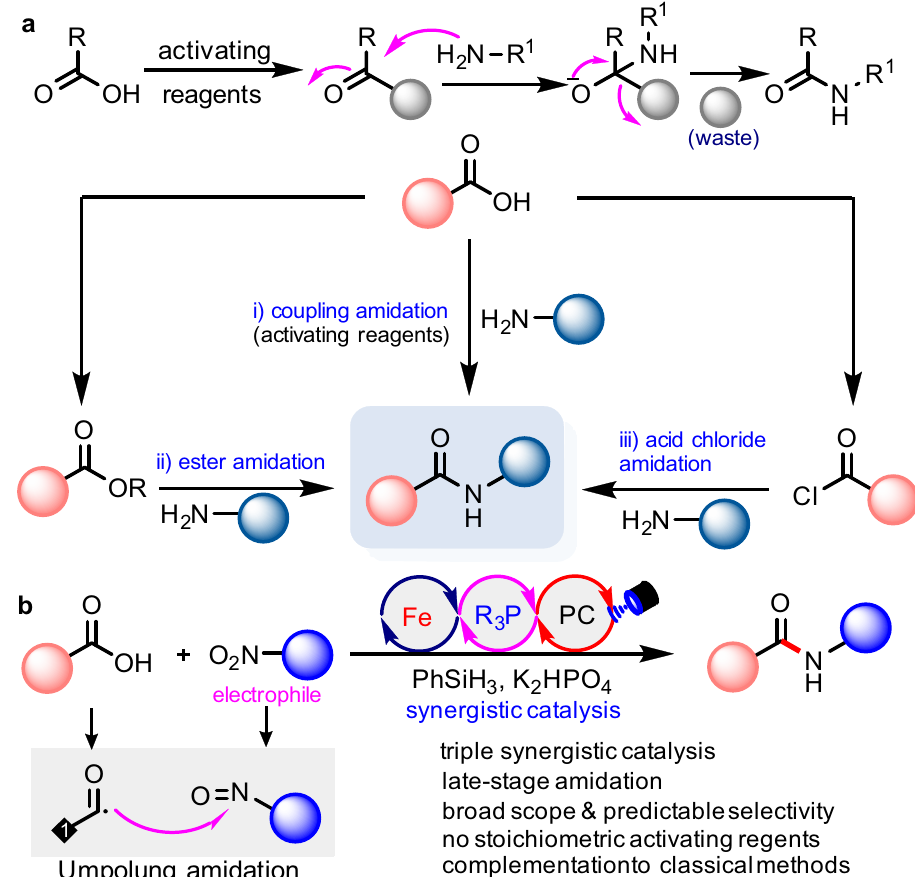
Fig. 1 The state-of-the-art of amidation of carboxylic acids. a Well-established amidation protocols of carboxylic acids. b Iron/P(III)/Photoredox catalysis for Umpolung amidation. PC